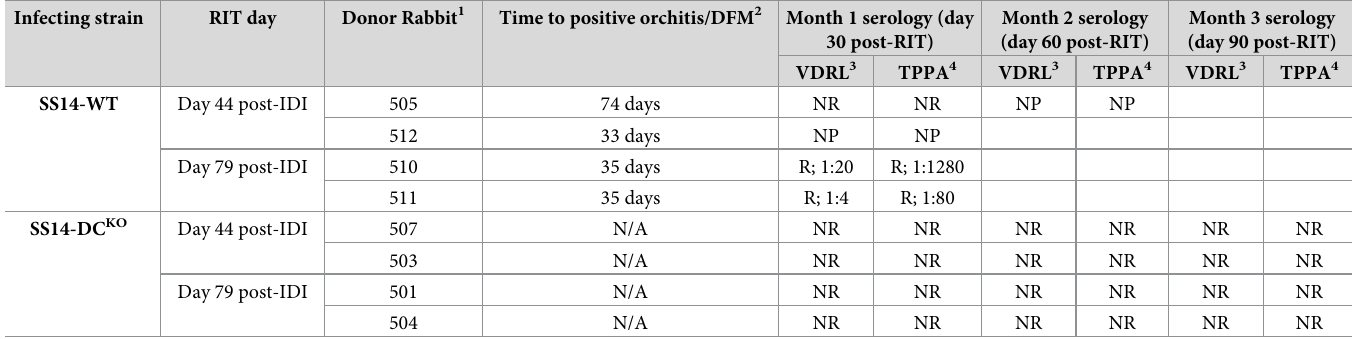
Table 2. Rabbit infectivity test